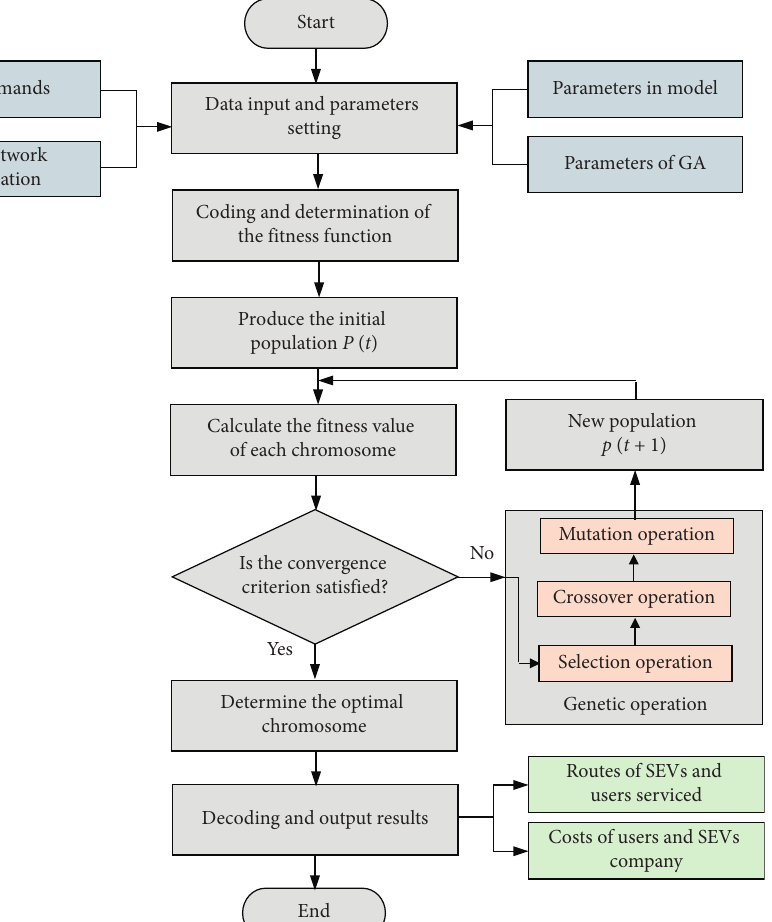
Figure 2: The solution process of the model using